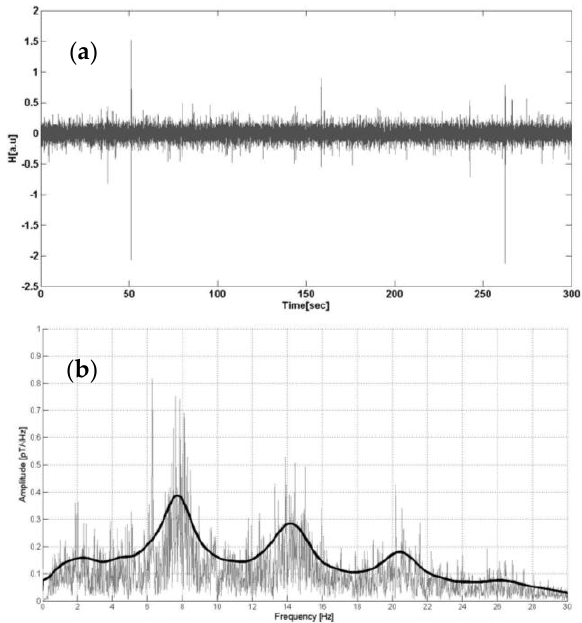
Figure 4. ( a ) Time series of five minutes of raw magnetic field data showing the background ELF field, together with transient ELF pulses; and ( b ) the spectrum of the time series showing the first four modes of the SR. The sum of Lorentzian fits to the data (black line) are also shown.